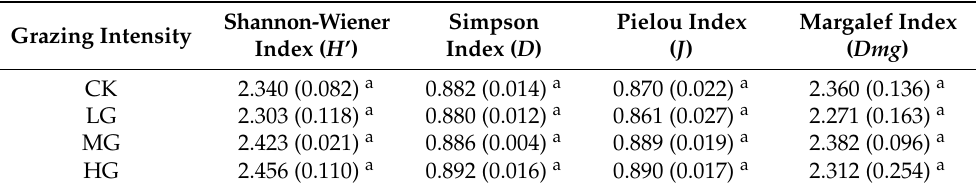
Table 2. The effects of grazing intensity on plant diversity indexes. CK, no grazing; LG, light grazing; MG, moderate grazing; HG, heavy grazing.